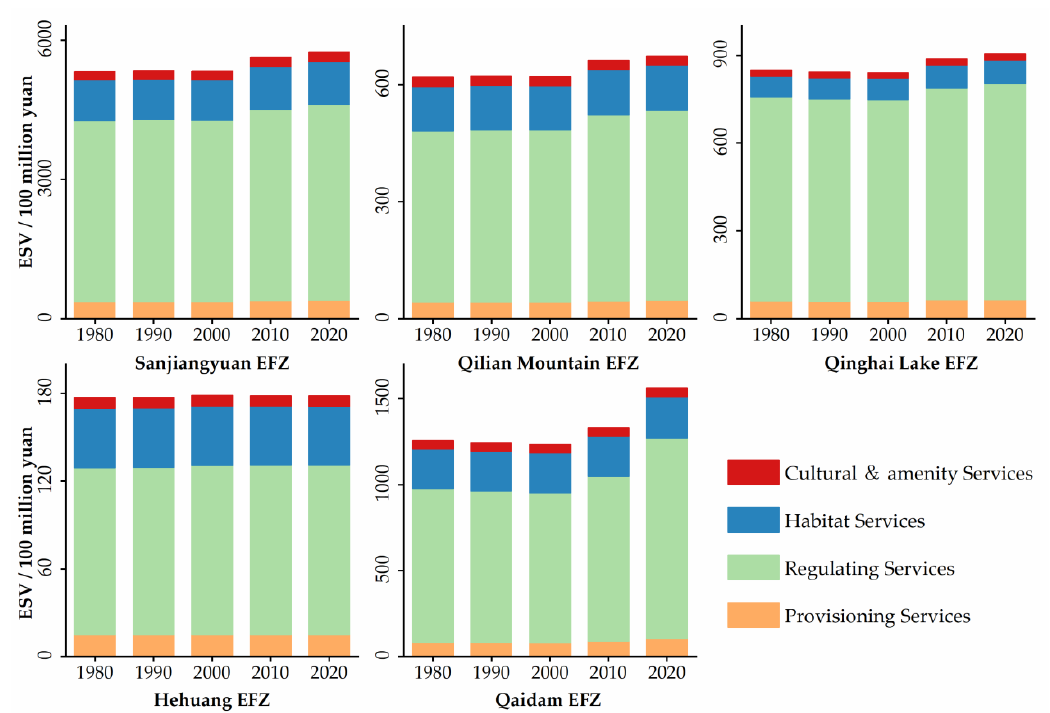
Figure 5. Structure chart of ecosystem service value of the five ecological function zones.